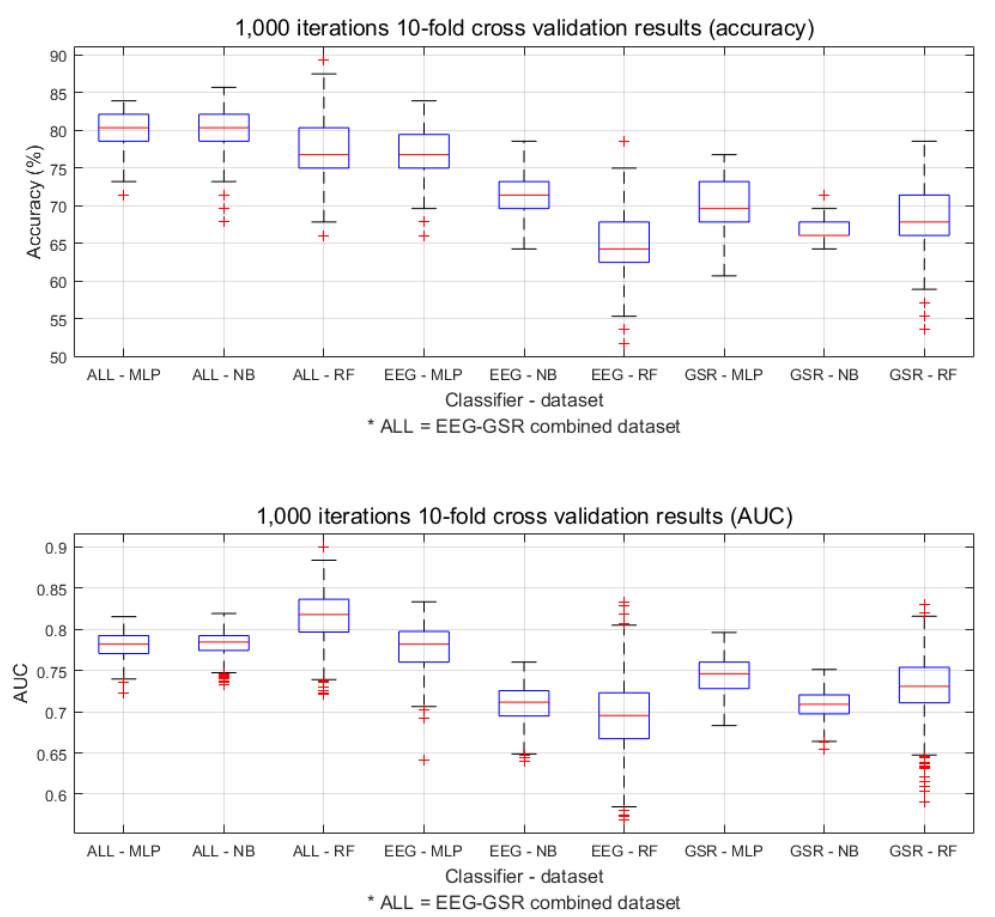
Figure 5. Box plots for the final performance